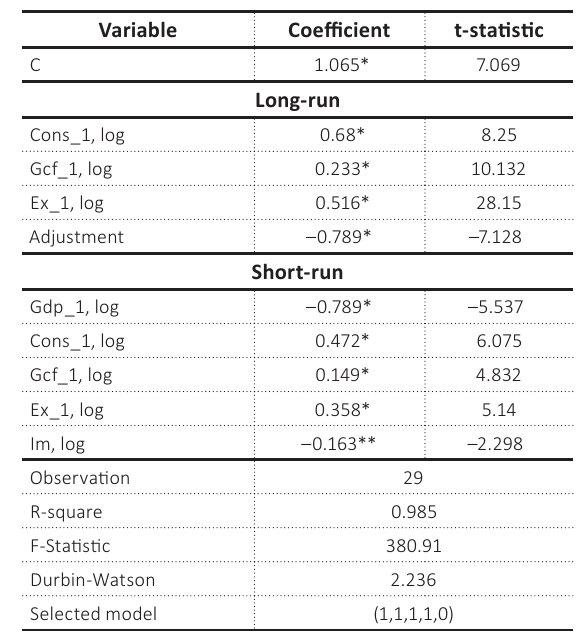
Table 4. ARDL ECM results